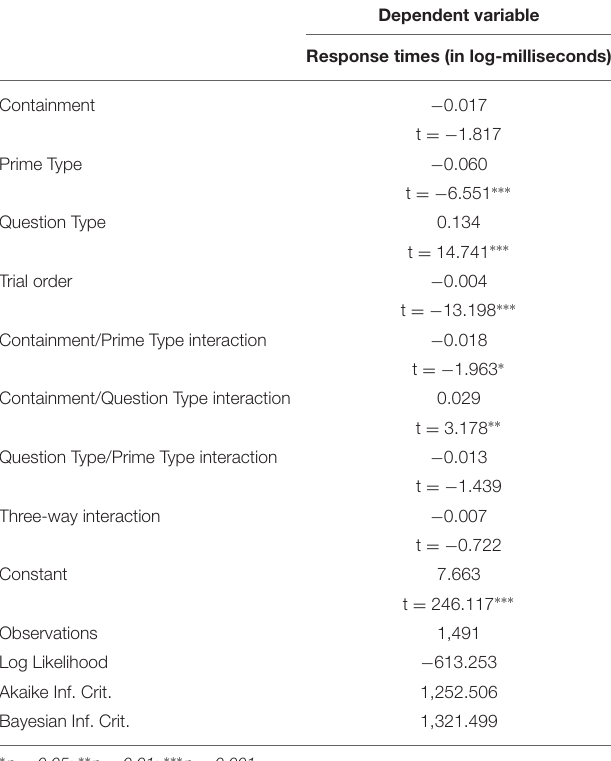
TABLE 10 | Regression analysis of response-times in Experiment 2.